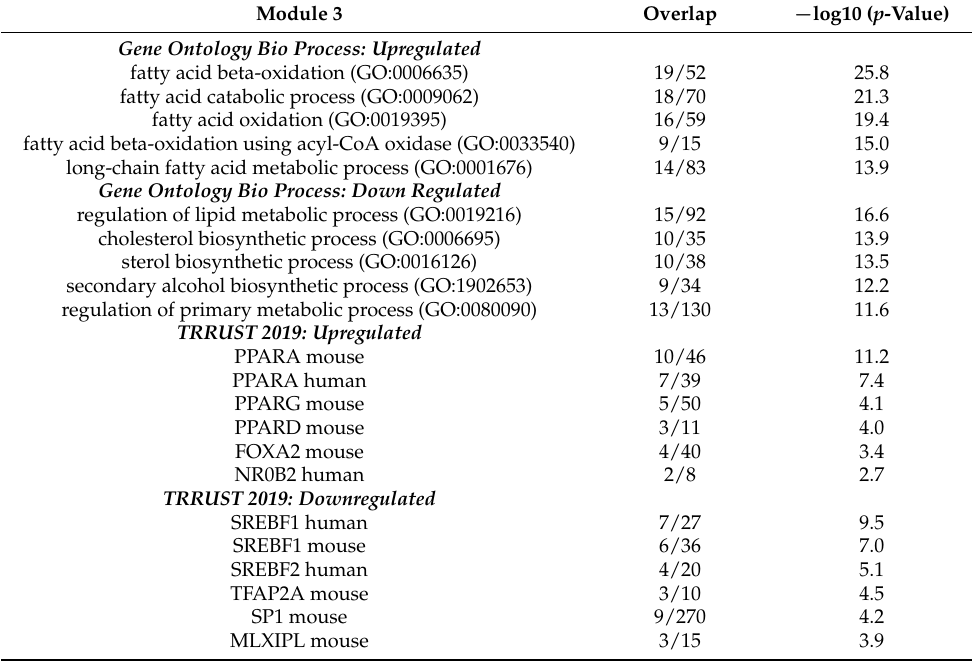
Table 3. Cont. Module 3 Overlap − log10 ( p